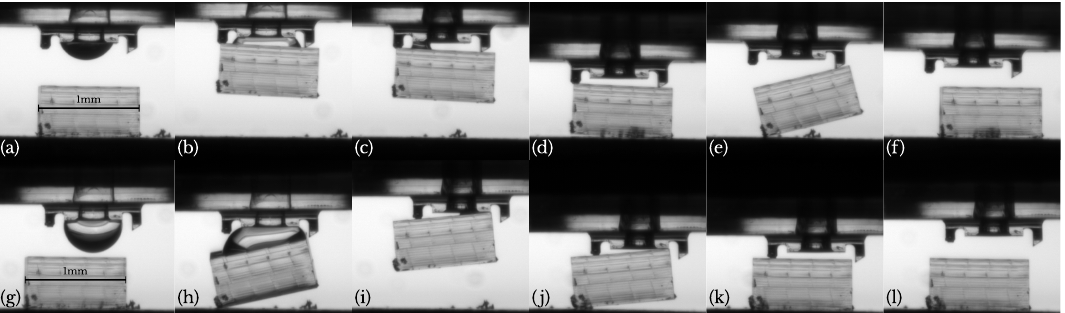
Figure 12. ( a – f )—correct picking but faulty release sequence ( e , f ) with the gripper from Section 4 (see video S2 in the Supplementary Materials). ( g – l )—correct single-pillar pick and release sequence (pillars on the right not in contact with the component) (see video S3 in the Supplementary